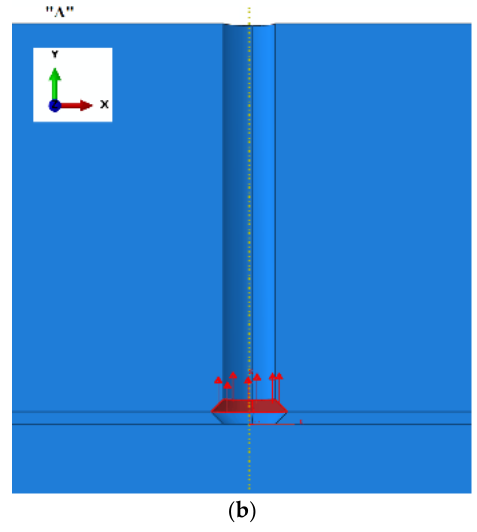
Figure 6. ( a ) Model restraints, ( b ) anchor loading.